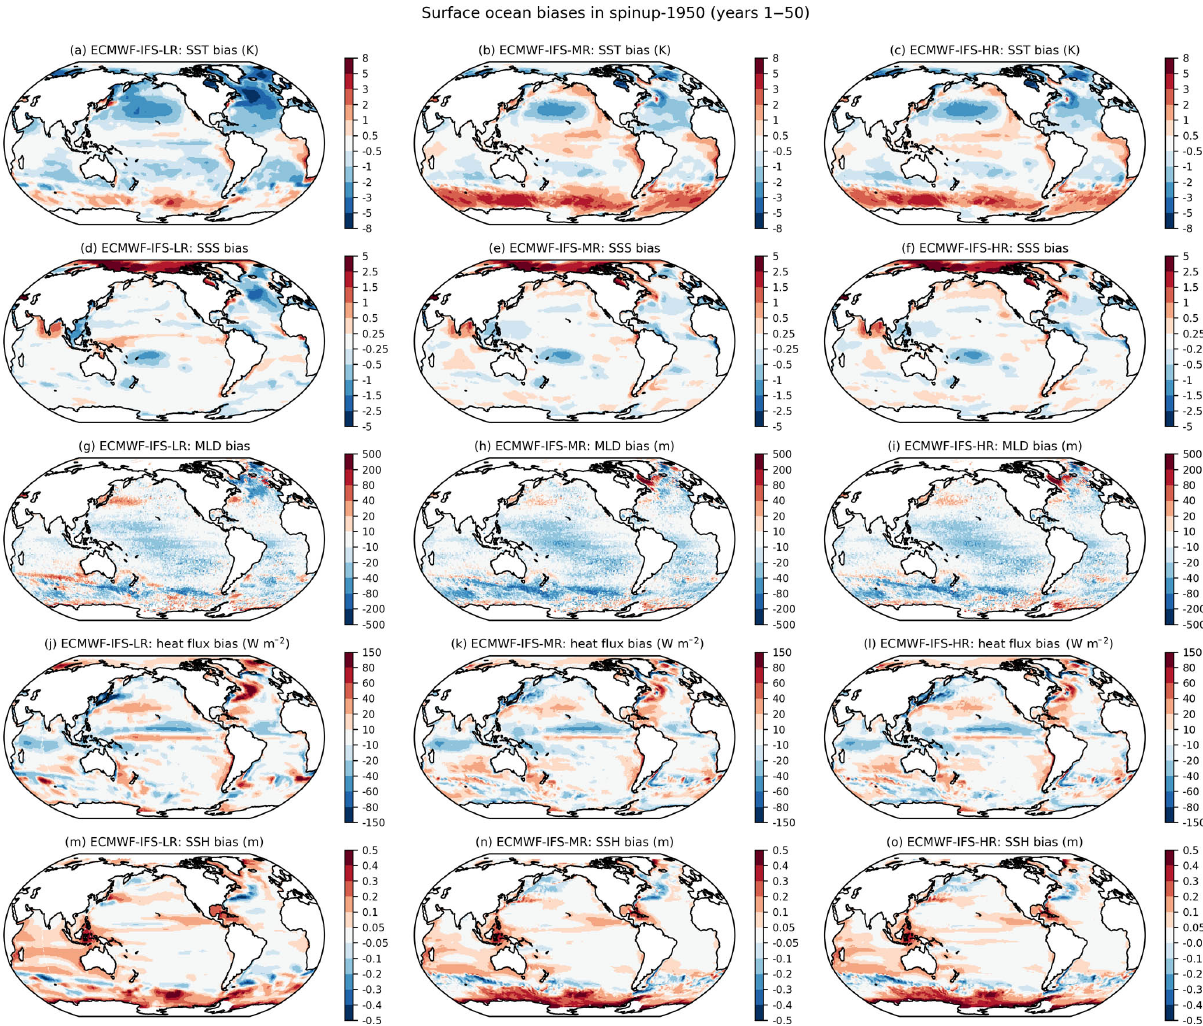
Figure 3. Climatological surface ocean biases calculated using years 1–50 of the spinup-1950 experiment. (a–c) Sea surface temperature (SST) and (d–f) sea surface salinity (SSS) biases relative to the EN4 climatology representative of the period 1950–1954 that was used to initialize the ocean (Good et al., 2013). (g–i) Annual mean mixed layer depth (MLD) biases relative to the Holte et al. (2017) Argo climatology. (j–l) Net surface heat flux biases (positive downwards) relative to the net heat flux derived from radiative fluxes at the top of the atmosphere combined with the mass-adjusted energy divergence in the ERA-Interim reanalysis (Liu et al., 2015, 2017). (m–o) Sea surface height (SSH) biases relative to satellite-derived estimates of absolute dynamic topography (AVISO,